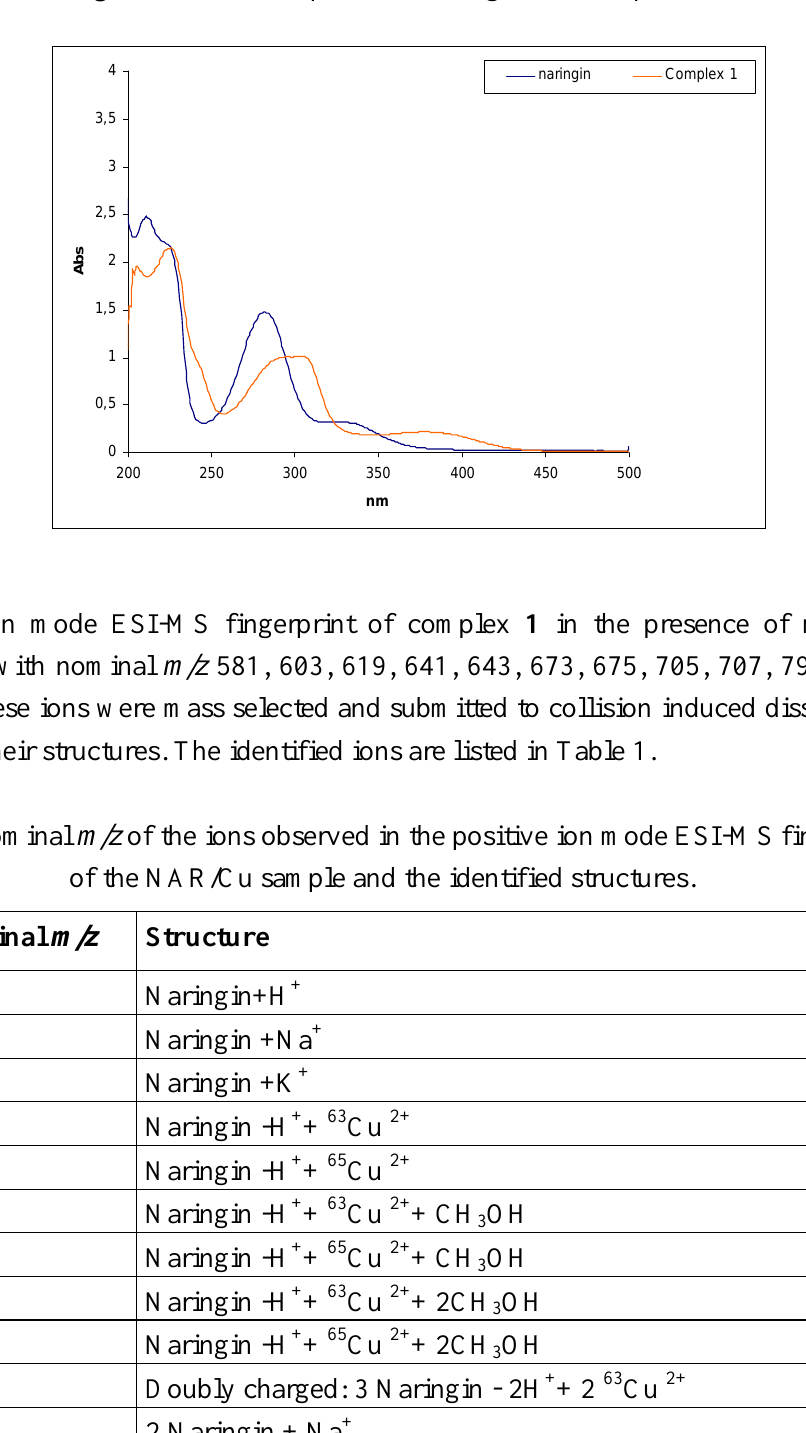
Figure 1. UV-VIS spectra of naringin and complex 1 .